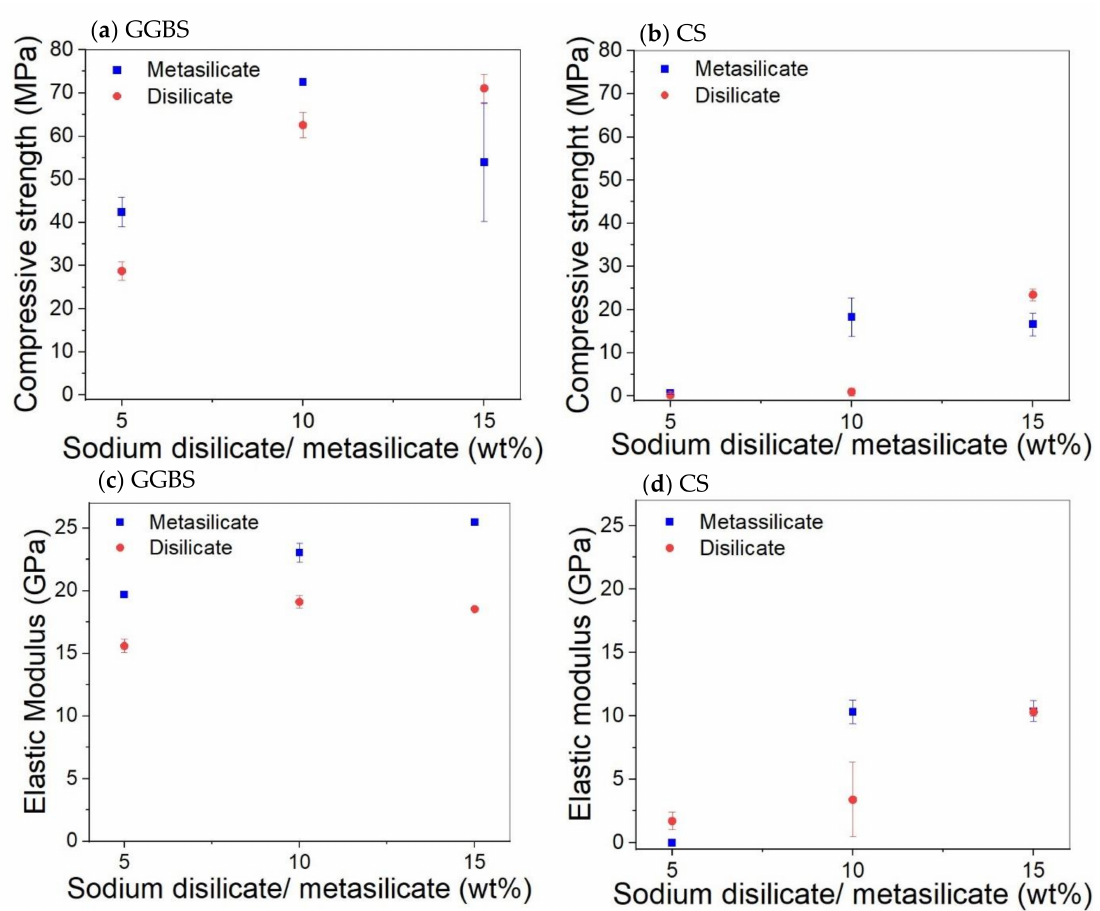
Figure 3. Effect of the amount of sodium disilicate/metasilicate on the compressive strength and elastic modulus of GGBS ( a , c ) and CS ( b , d ) based systems at 28 days.